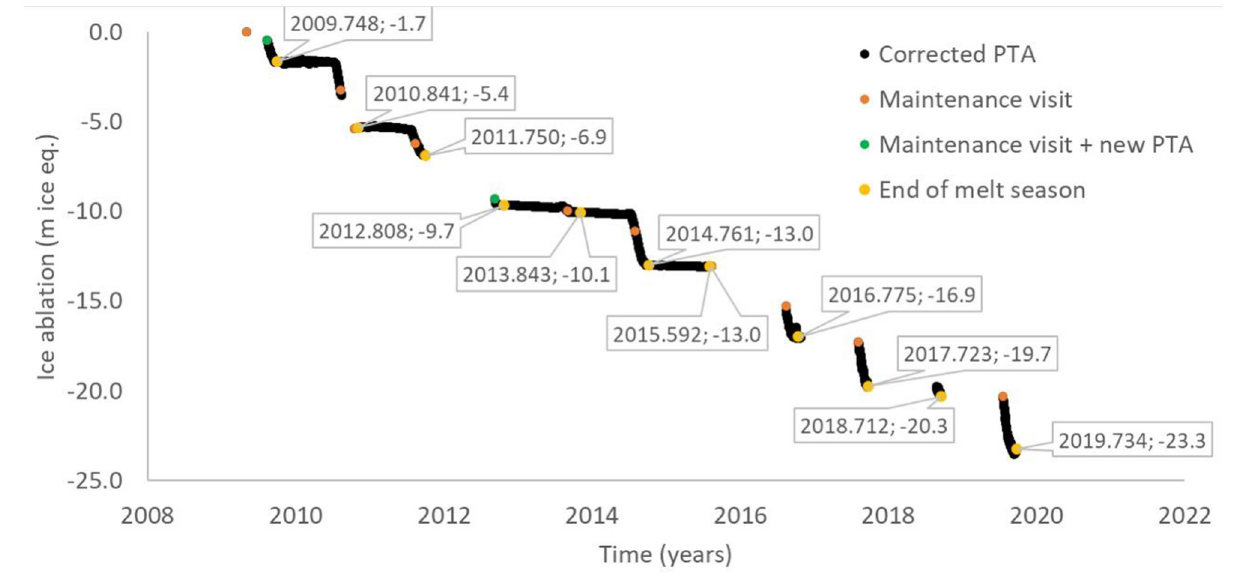
Frontiers in Earth Science |